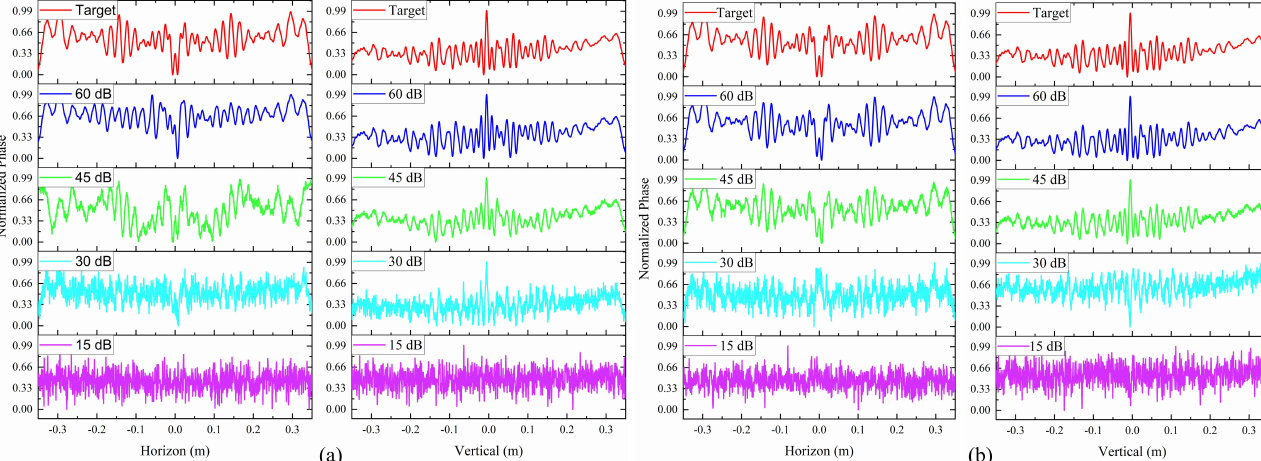
Figure 12. The phase retrieved by the GS/HIO algorithm ( a ), and the proposed algorithm ( b ) with different SNRs: The comparison of the normalized target phase and the normalized retrieved phase on the horizontal axis and vertical axis with the range of the quiet